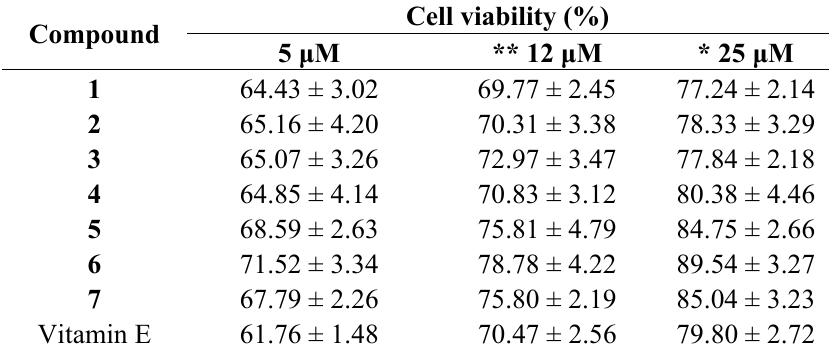
Table 3. Neuroprotective effects of Compounds 1 – 7 against A β -induced PC12 cells death. 25–35 Cell viability (%) Compound 5 μ M